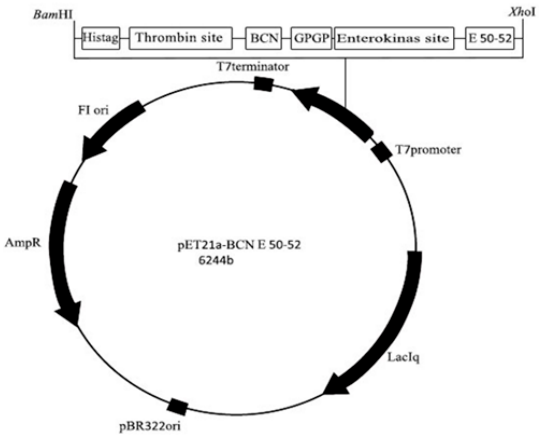
Figure 5. Design of the expression vector pET21a-BCN E 50-52 . BCN: beta casein. GPGP: Double repeat of Glycine Proline as a flexible linker between two different proteins.